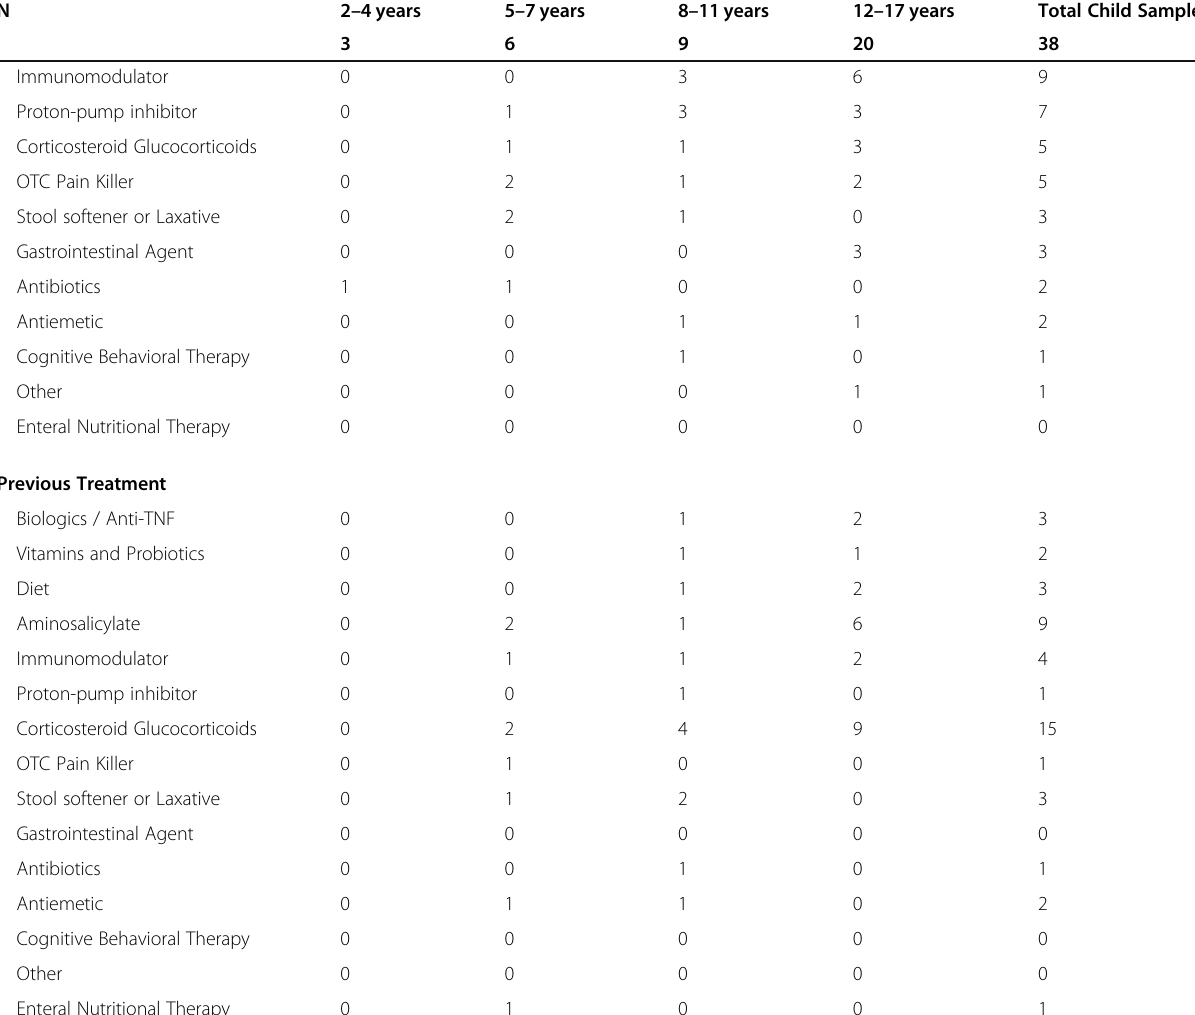
Table 2 Clinical Characteristics of Children with CD